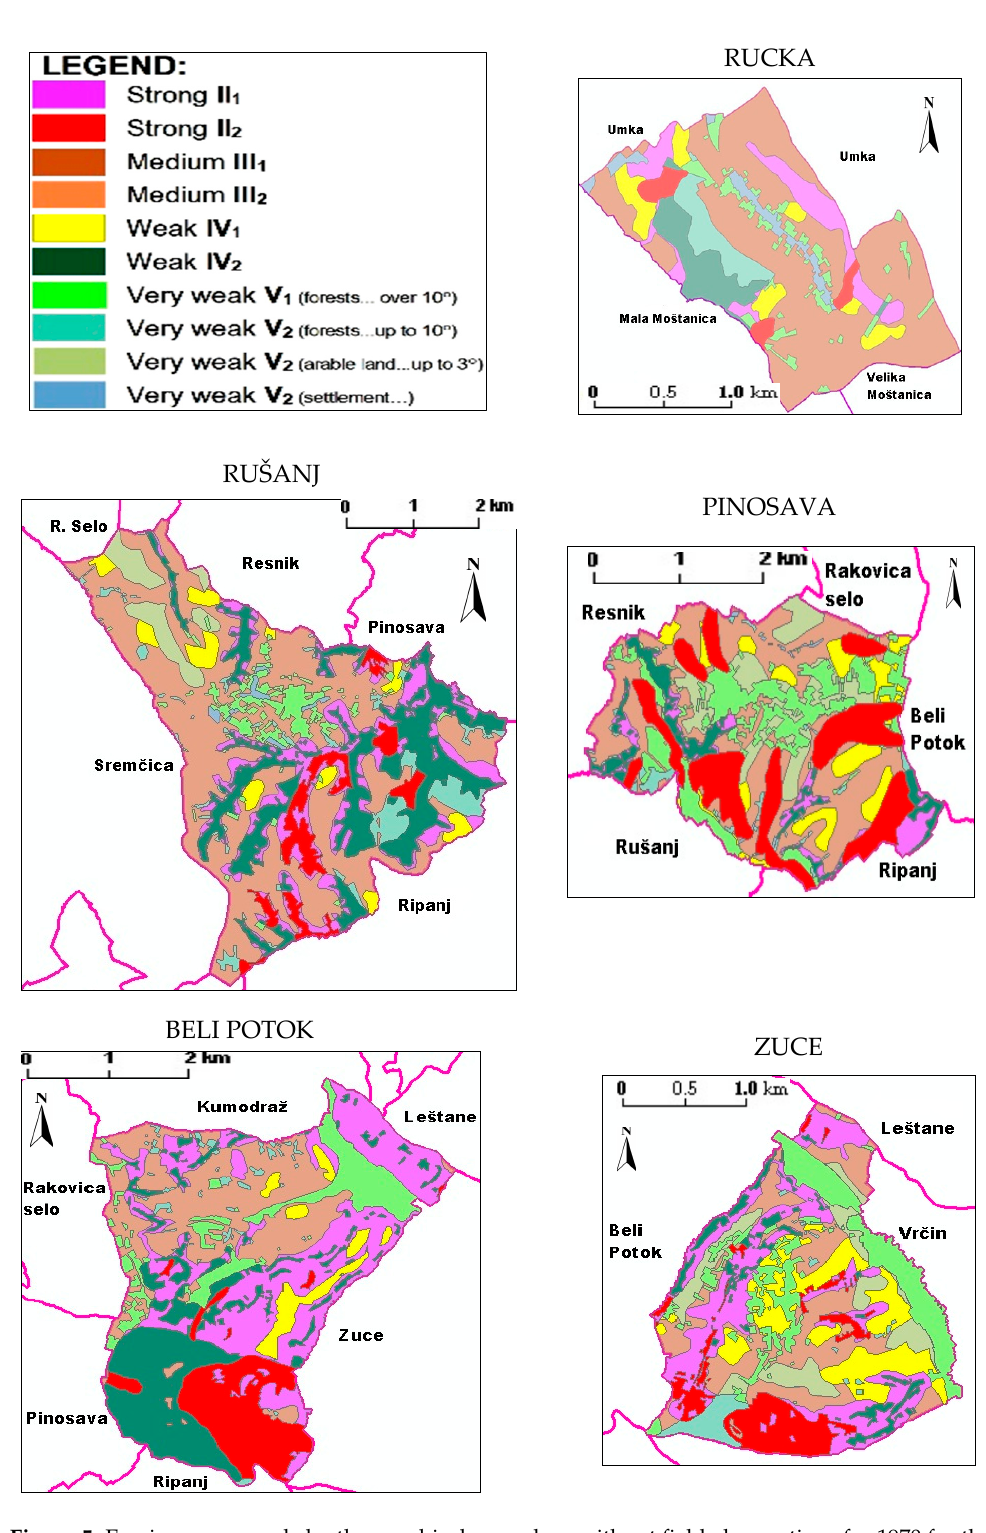
Figure 5. Erosion maps made by the graphical procedure without field observations for 1970 for the settlements Rucka, Rušanj, Pinosava, Beli Potok, and Zuce. Erosion categories and coefficients are listed in Table S4.